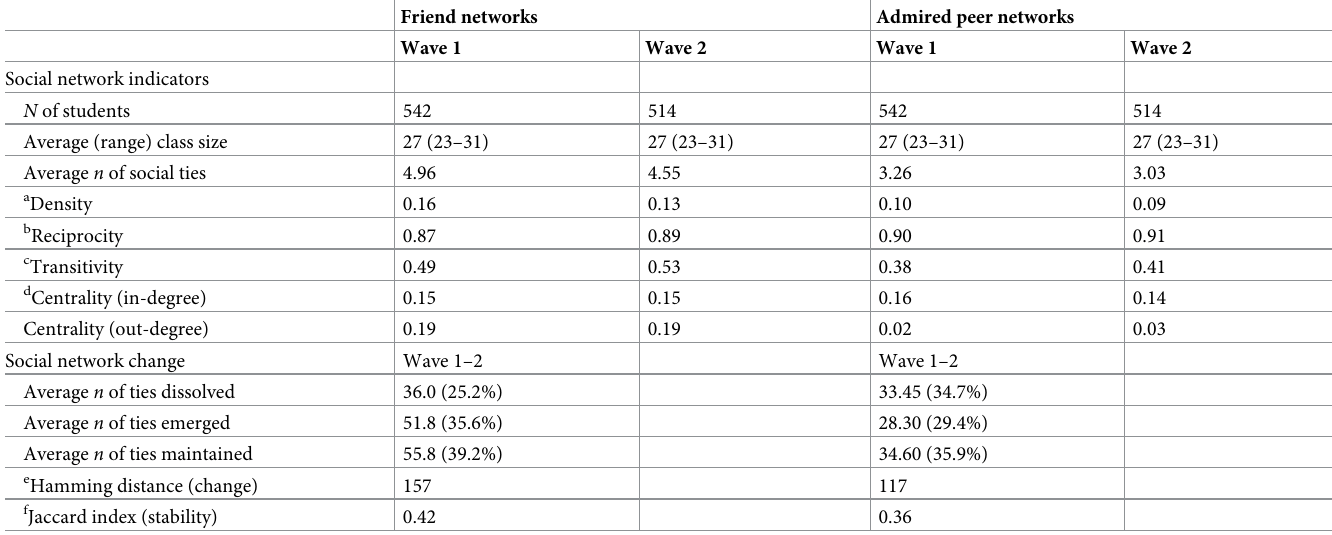
Table 2. Changes in early adolescents’ social